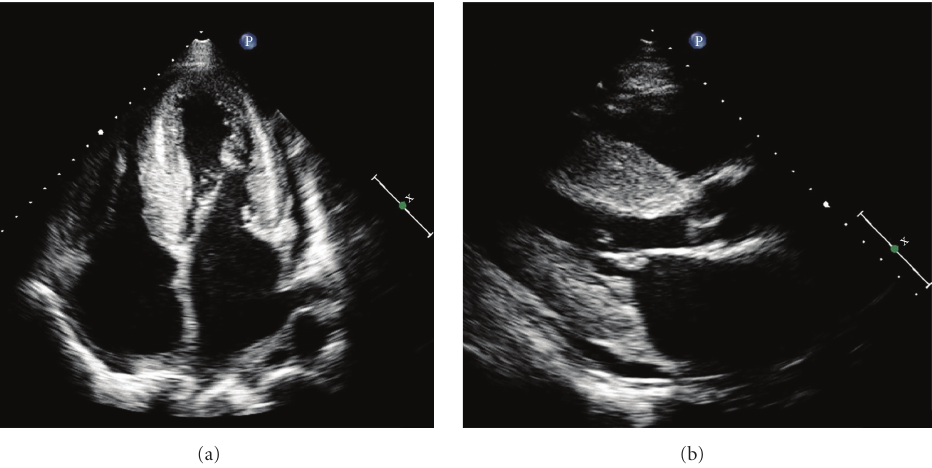
Figure 1: Transthoracic echocardiography in apical 4-chamber view (a) and parasternal view (b), demonstrating a small left ventricle with severe concentric left ventricular wall thickening with “sparkling” appearance, mitral valve leaflet and interatrial septal thickening, biatrial enlargement, and mild circumferential pericardial e ff usion in patient with cardiac amyloidosis.